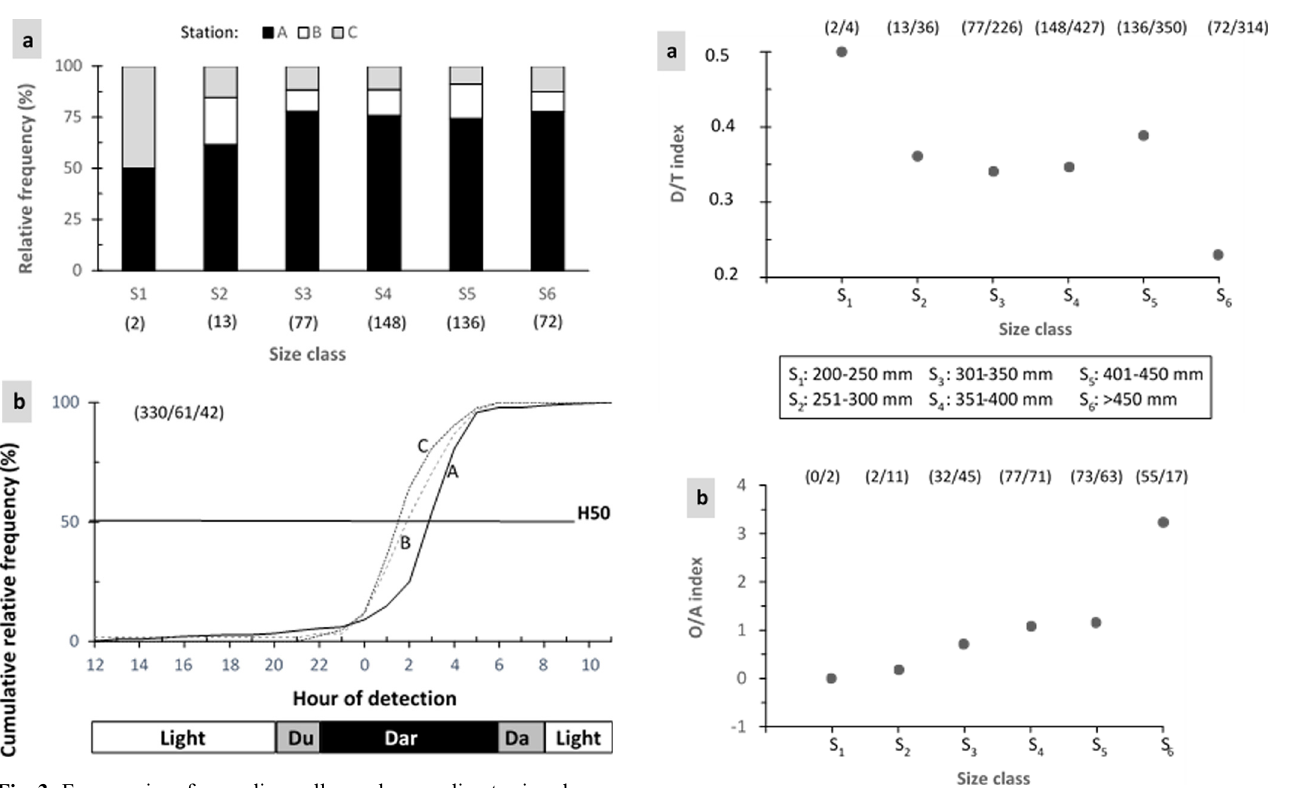
Fig. 3. Frequencies of ascending yellow eels according to size classes (a) and hour of detection (b). H50 indicates the hour of detection of 50% (median) of the eels; A , B and C specify detection stations at the fi rst upstream detection station A (Monsin) in the Meuse, B (Yvoz- Ramet) on route 1 in the upper Meuse, and C (Angleur) on route 2 in the Ourthe tributary. Numbers in brackets indicate the sample size of eels detected by size classes and stations A , B and C , respectively. Du and Dar correspond to dusk and dawn,